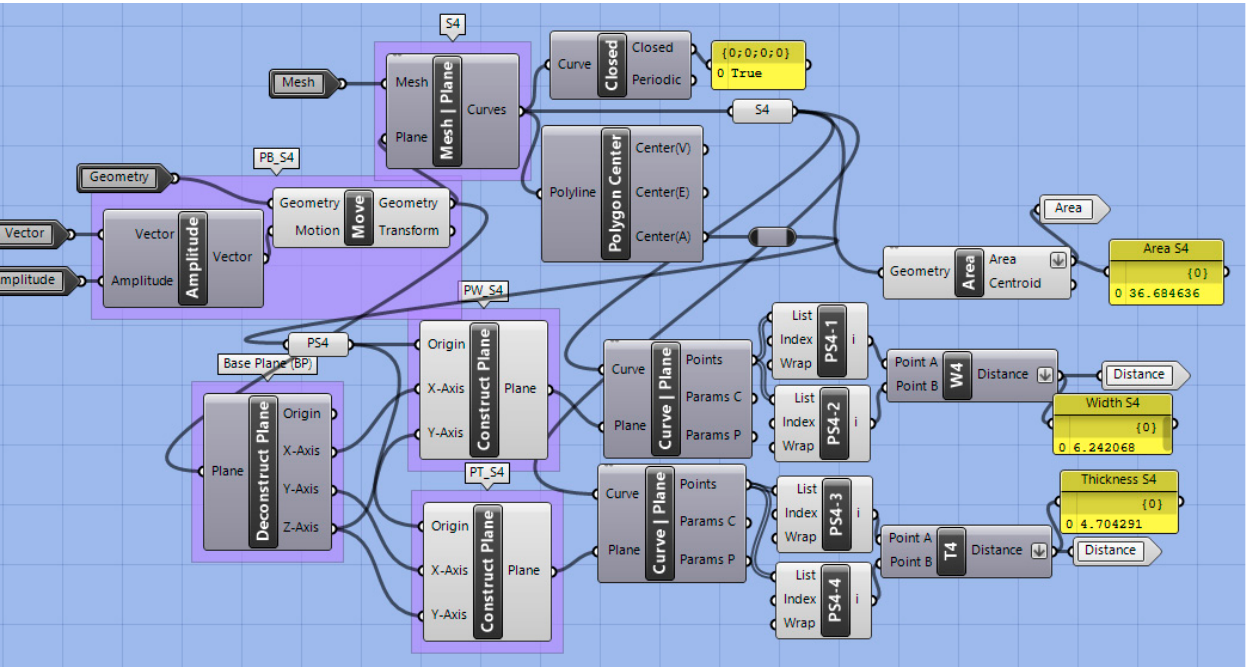
Figure 10. Clustered GH code part for sectioning and measuring the TPP extension. Example for Section 4.